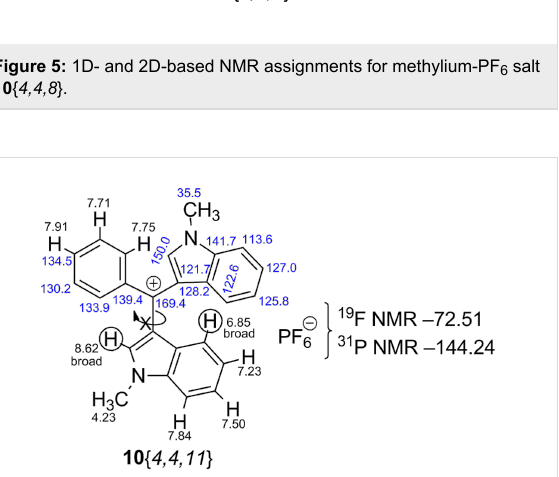
Figure 5: 1D- and 2D-based NMR assignments for methylium-PF 6 salt 10 { 4,4,8 }.